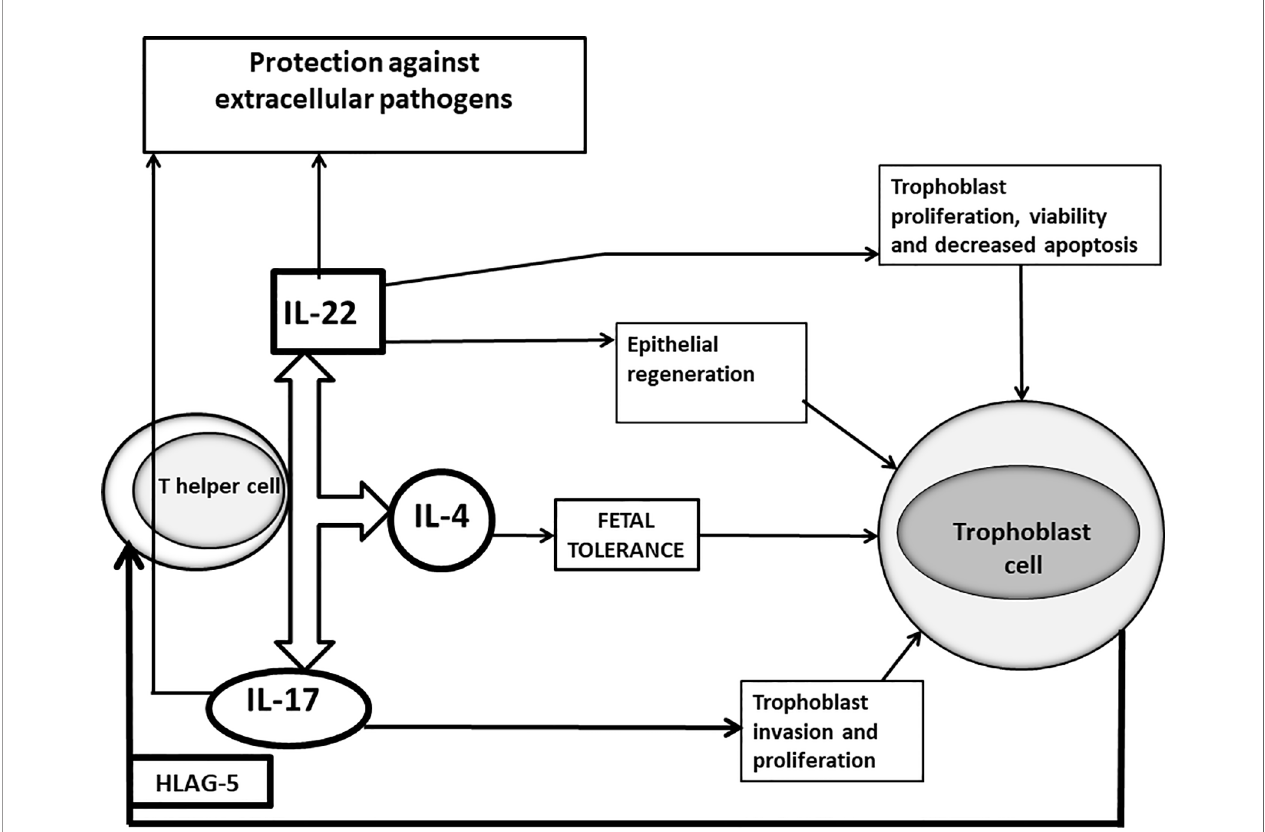
FIGURE 1 | Positive roles of IL-17 and IL-22 at maternal fetal interface of successful pregnancy. In successful pregnancy where IL-17 is produced in association with IL-4 by Th17/Th2 cells stimulated by trophoblast-derived HLA-G5, IL-17 could have a positive in fl uence on pregnancy, by inducing trophoblast proliferation and invasion and by protecting the mother from extracellular pathogens, responsible for miscarriages. IL-22, when it is produced in association with IL-4, could also positively affect pregnancy by repairing damage of the trophoblast cells, by inducing the proliferation, survival and decreased apoptosis of trophoblast cells and by stimulating epithelial cells to secrete antimicrobial peptides supporting the defense against